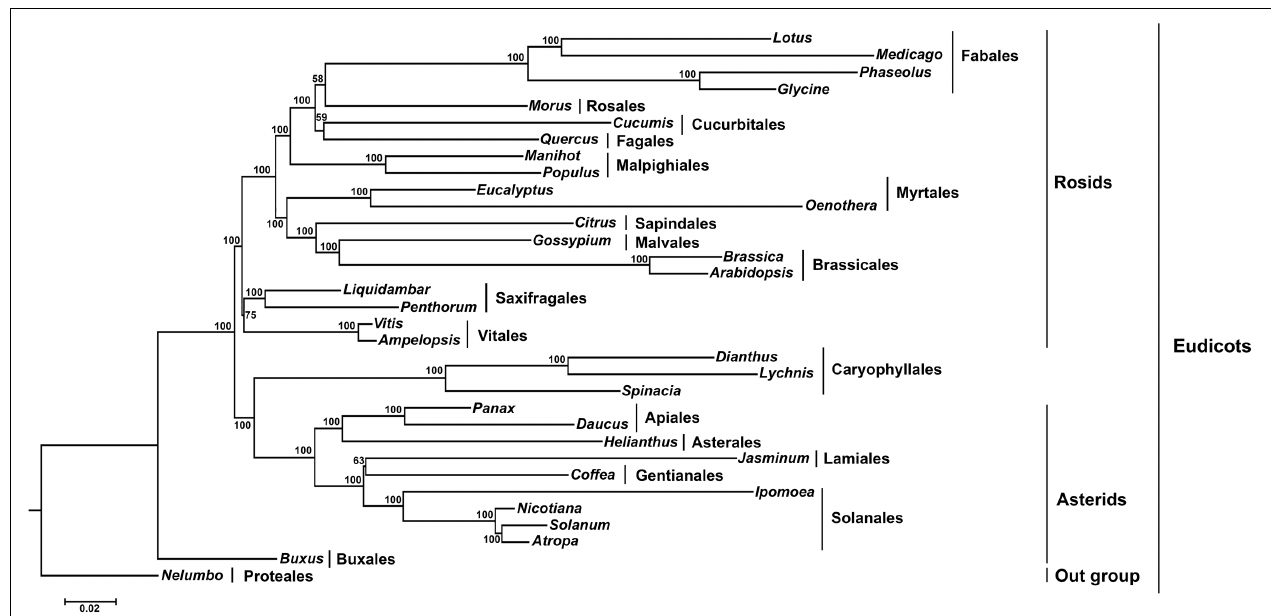
FIGURE 6 | Molecular phylogenetic tree of 33 angiosperms based on 70 protein-coding genes in the cp genome. The tree was constructed by maximum likelihood (ML) analysis of the conserved regions using the RaxML program and the GTR + I nucleotide model. The stability of each tree node was tested by bootstrap analysis with 1000 replicates. Bootstrap values are indicated on the branches, and the branch length reflects the estimated number of substitutions per 1000 sites. Nelumbo was set as the